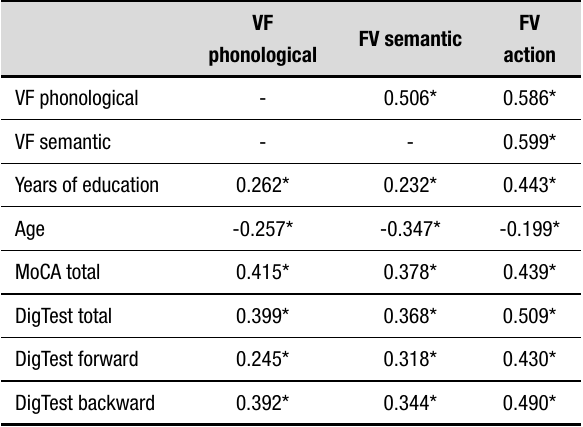
Table 2. Bivariate